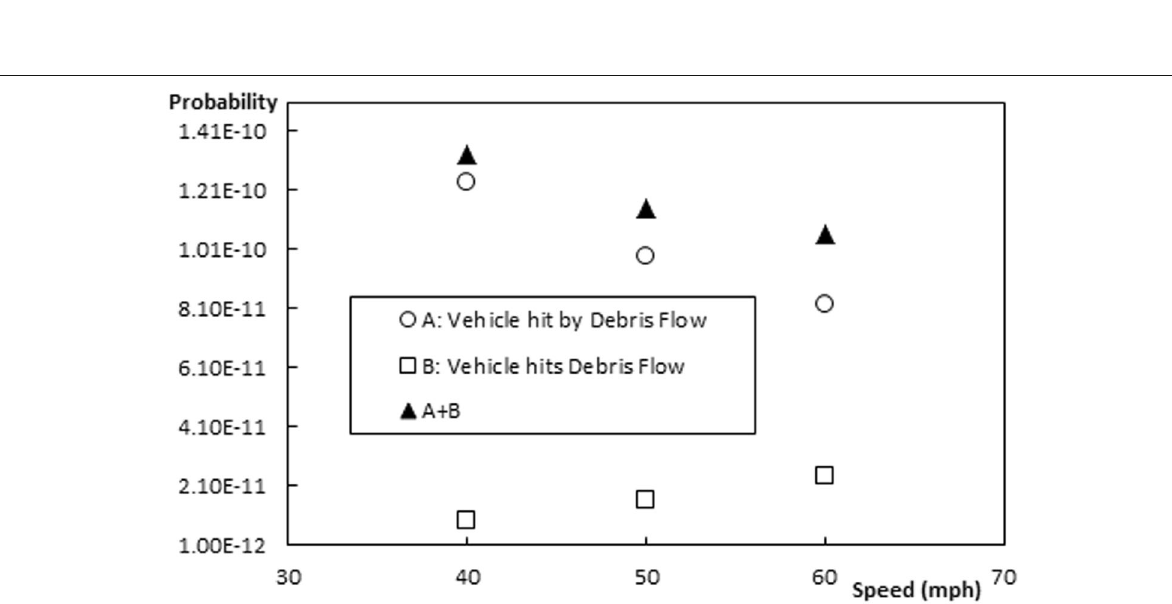
Fig. 17 The variation of PIR for the two risk scenarios and total risk with speed at the A85 Glen Ogle. A similar pattern is evident for the A83 site albeit with different